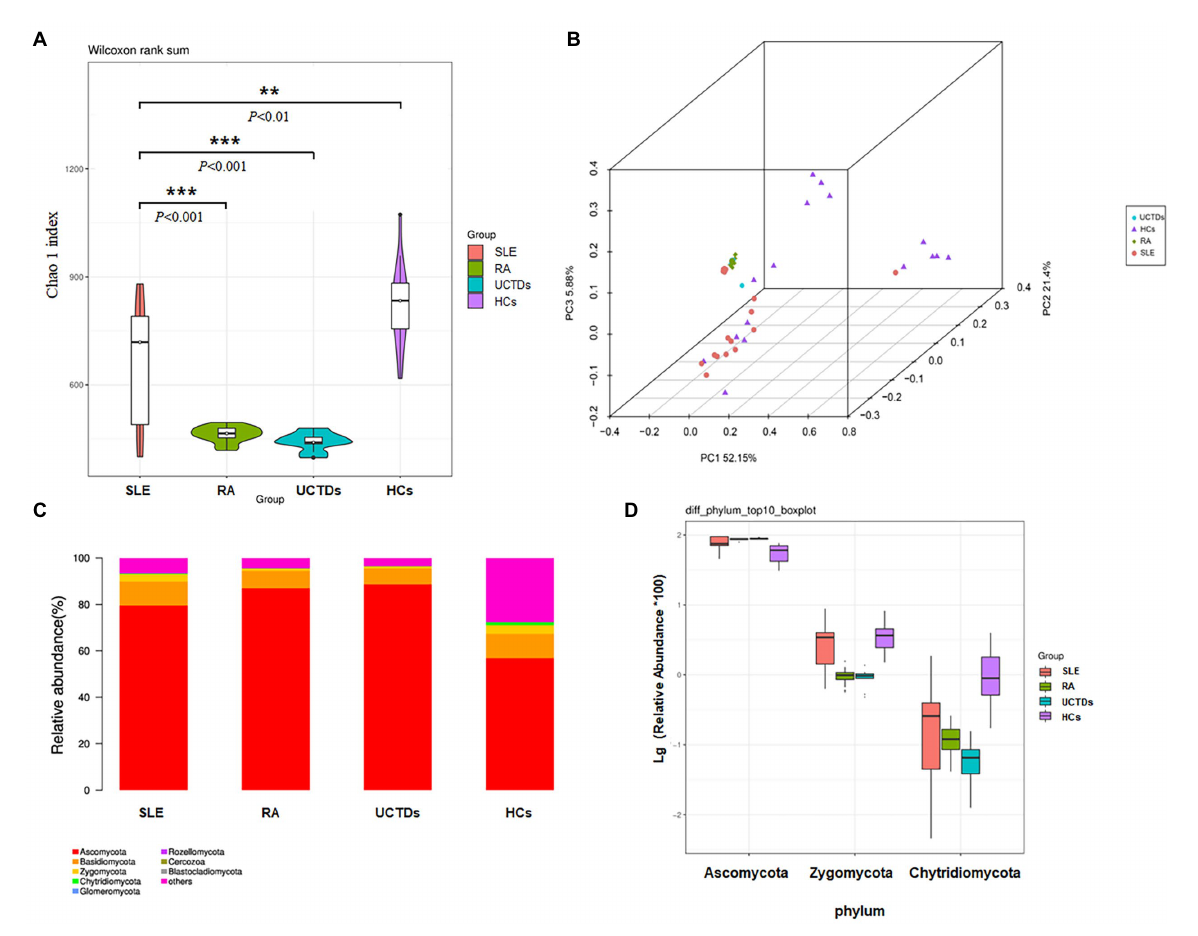
FIGURE 1 Diversities and relative abundance of gut fungi between SLE, RA, UCTDs and HCs. (A) Alpha diversities with Chao 1 index for SLE compared with HCs, RA and UCTDs; (B) principal coordinate analysis (PCoA) on Bray-Curtis distance of the fungal microbiota community structures in SLE, HCs, RA and UCTDs; (C) the relative abundance of fungi at phyla level of SLE, HCs, RA and UCTDs; (D) the relative abundance of fungi at the phylum level differ between SLE, HCs, RA and